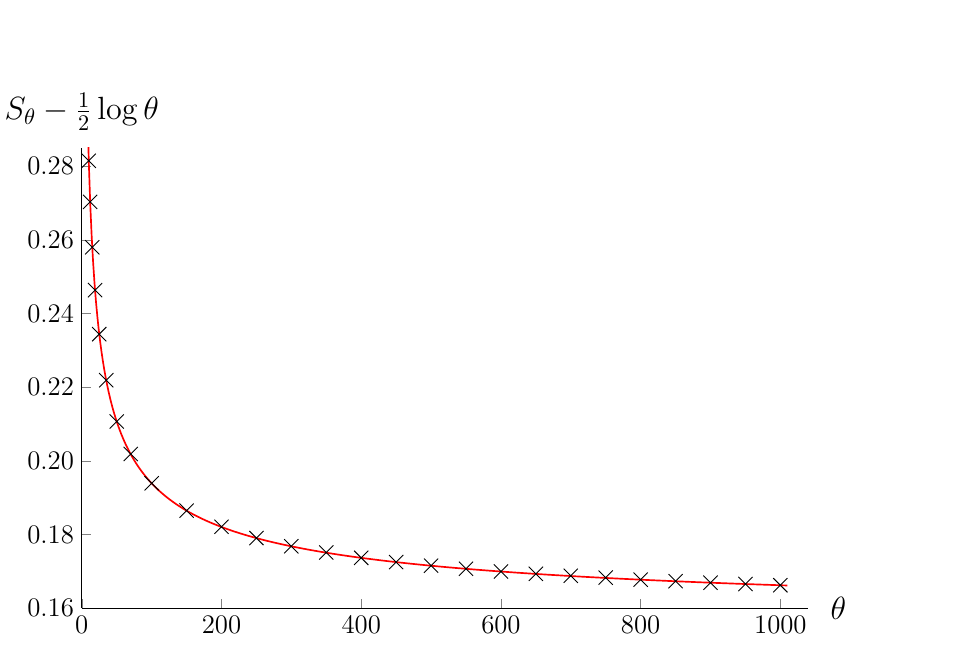
1100 p; p 0 1100. The solid line is the (cid:0) (cid:20) (cid:20) [500 ; 1000]; we obtain (cid:11) = 0 : 15343 2